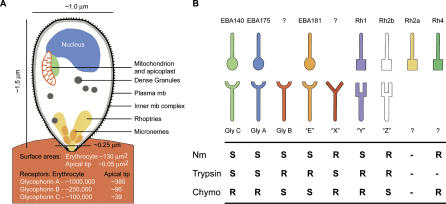
A Number of Receptor–Ligand Interactions Mediate Merozoite Invasion of the Erythrocyte(A) Estimates for the dimensions of the interaction between the apical merozoite tip and the erythrocyte surface suggest a finite number of receptors may, together with parasite ligands, direct invasion (dimensions based on [55]; receptor figures based on [56]).(B) Known receptor–ligand interactions between the invading merozoite and erythrocyte surface receptors and their enzyme sensitivities to neuraminidase (Nm), trypsin, and chymotrypsin (Chymo). S indicates sensitivity of invasion to this enzyme (inhibits invasion/ligand-binding). R indicates resistance (does not inhibit invasion/ligand-binding). Unknown ligands or receptors are indicated by a “?,” with unknown receptors E, X, Y, and Z known only from their enzyme sensitivities. Dots in table indicate that no data are available. Data are taken from [7,8,10–12,14,17,27,33,45].